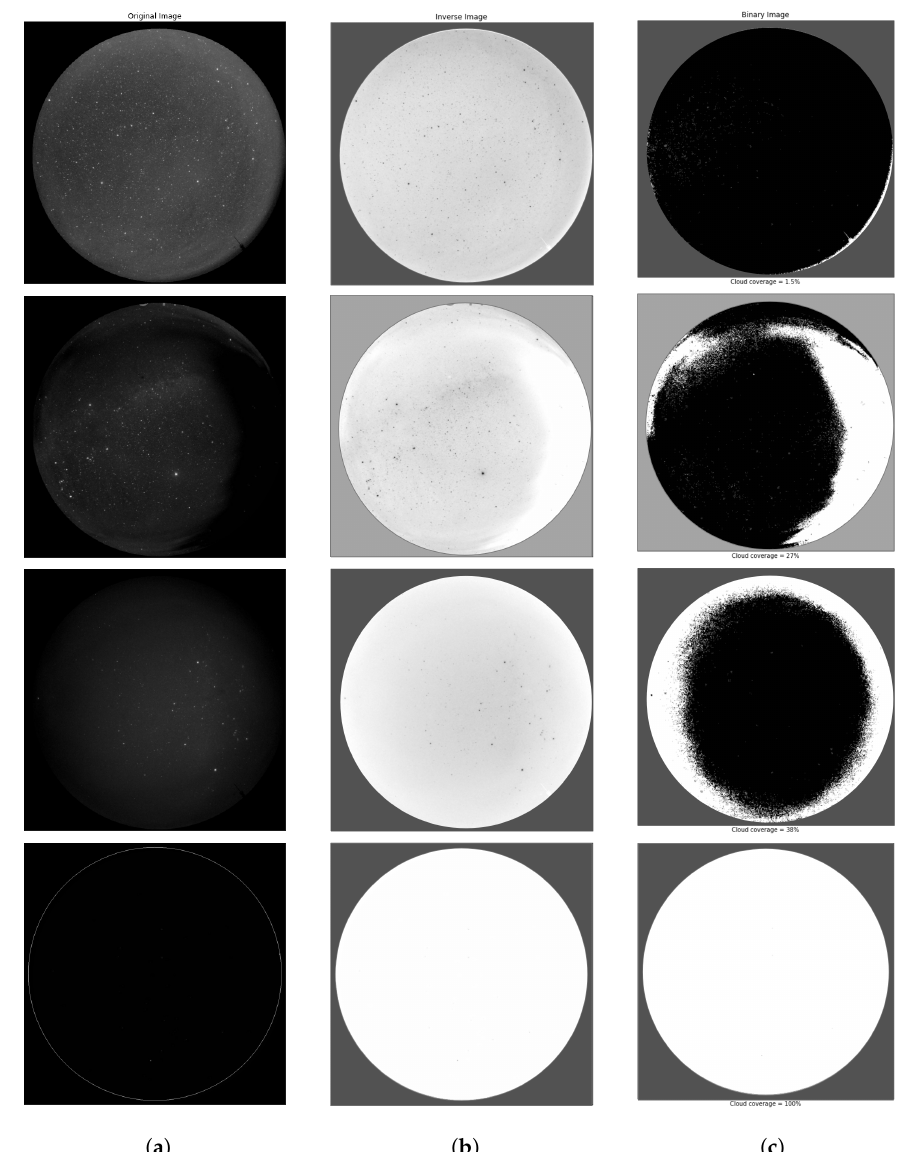
Figure 9. Four different sky conditions for NMIs. ( a ) Original NMIs. ( b ) Inverted color map NMIs. ( c ) Segmentation map, where the black color represents the regions clear of clouds and the white color corresponds to regions covered by